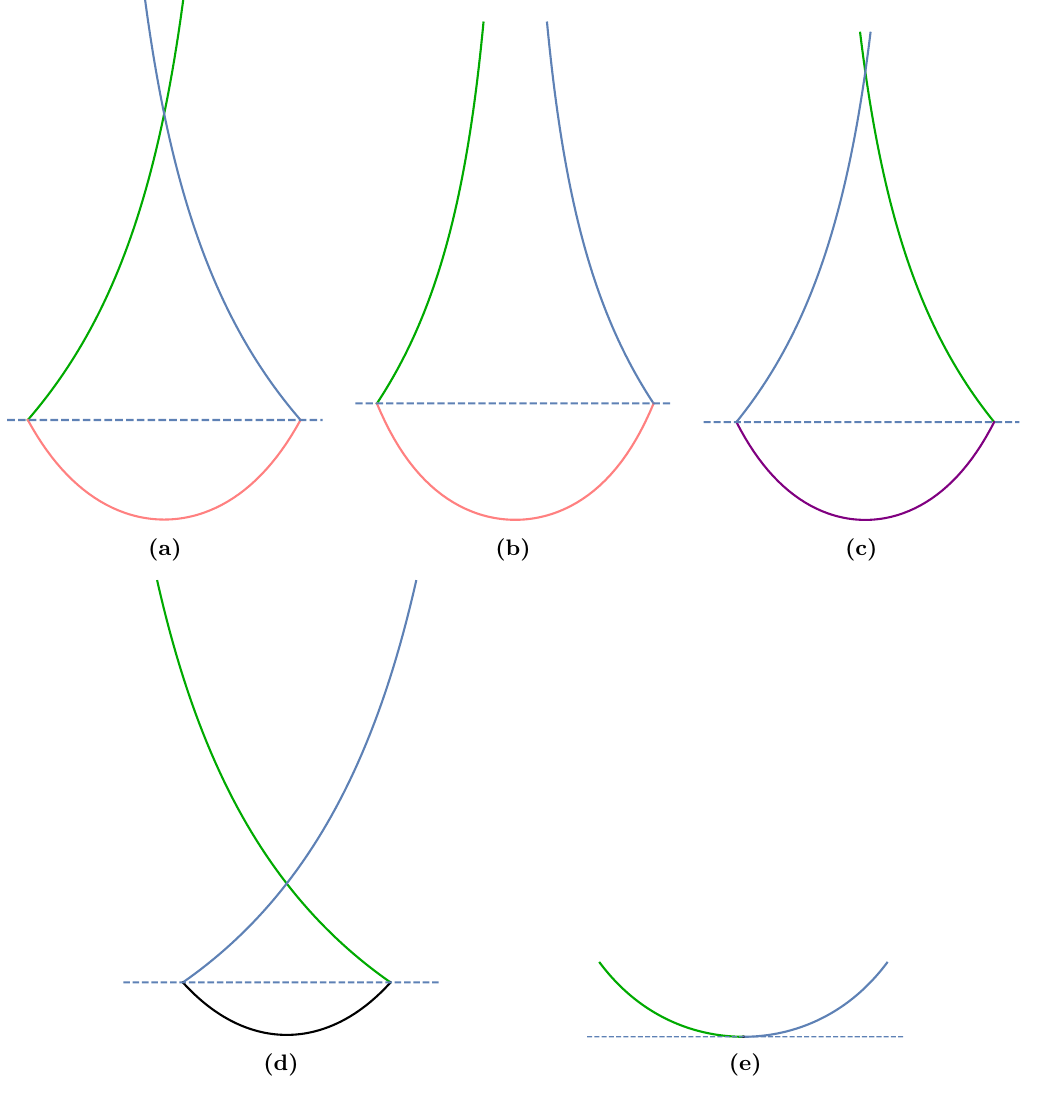
Figure 13 . Second part of geodesic